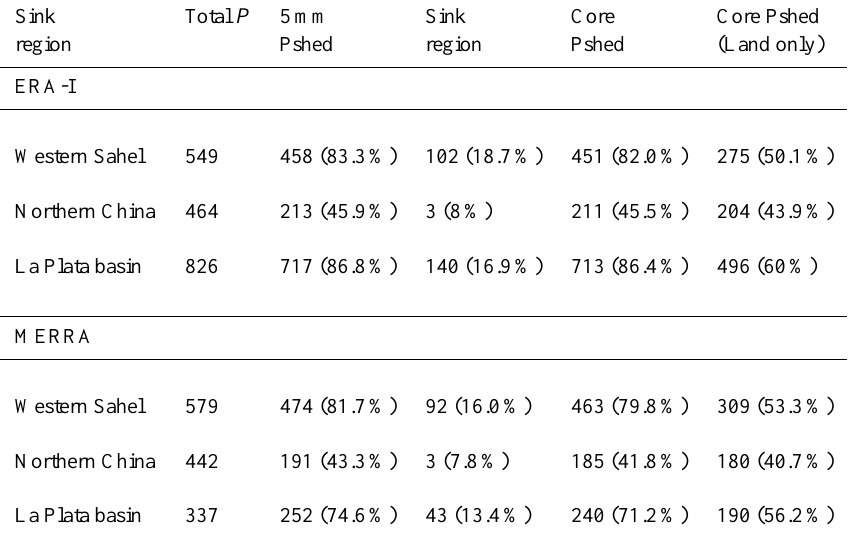
Table 2. Depths of precipitation (in mmgrowingseason − 1 ) provided by the corresponding precipitationshed; fractions of total are indicated in parentheses. Note that “precipitation” is abbreviated to P , and “precipitationshed” is abbreviated to